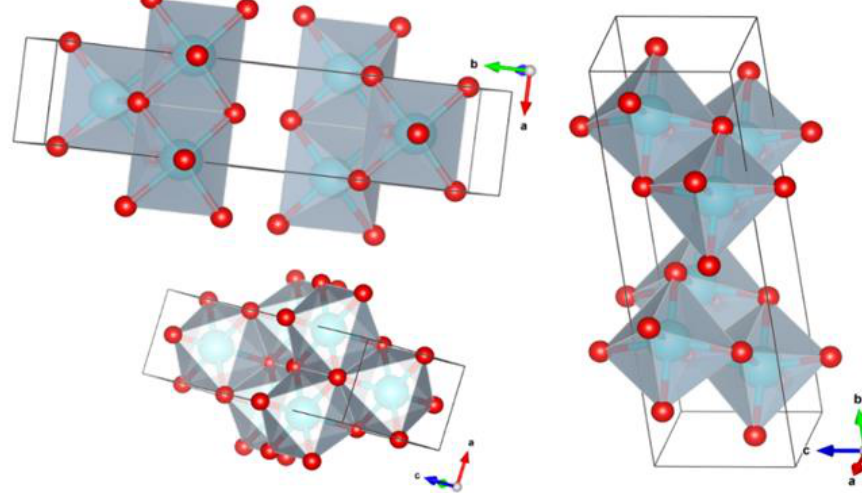
Figure 1. Crystal structure of boehmite. Crystallographic Open Database ID: 9012253.